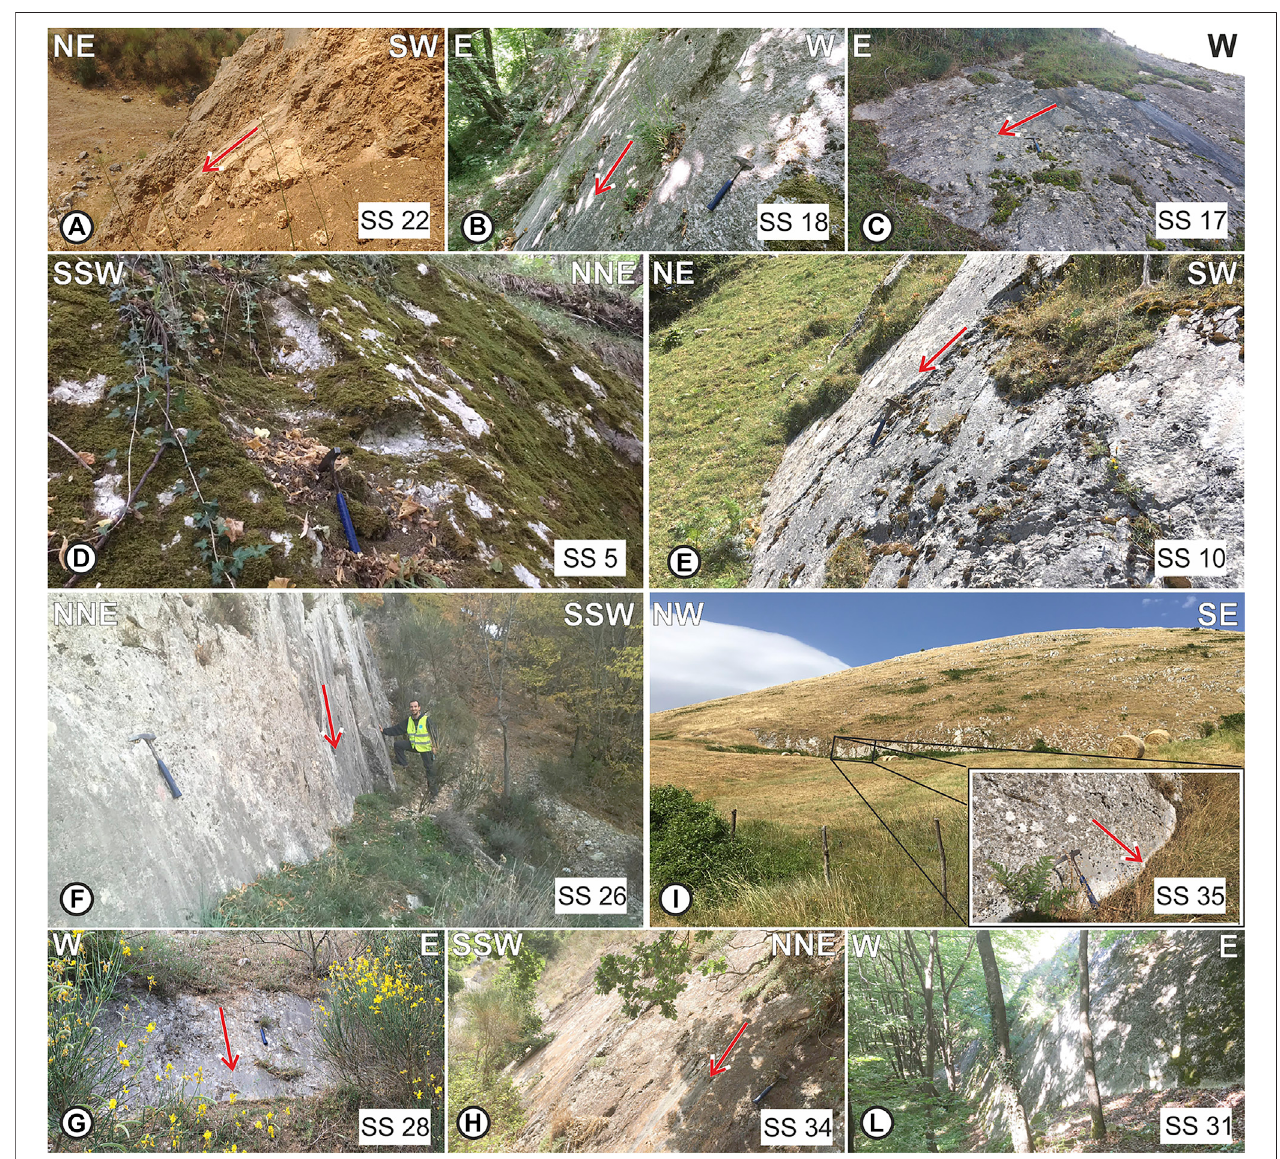
FIGURE 6 | Outcrop views ofthe Quaternary normal faults mapped in the study area (locations in Figure 3 as small white circles) (A,B) refer to InIF; (C) to the E-W Irpinia; (D,E) to IF; (F,G) to minor antithetic structures in the PB and PSGM basins; (H,I,L) refer to AFA. Red arrows indicate the sense of slip given by the slickenlines measured on the fault plane. On each picture the number of the SS located in Figure 6 is also indicated.